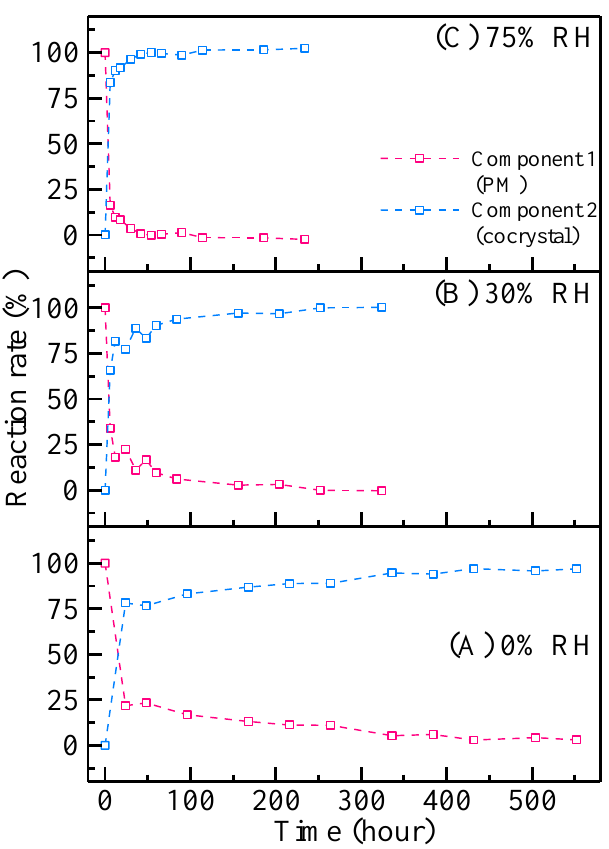
Figure 4. Reaction rate in the 1832–2229 cm –1 region of the FT-IR spectrum. Red and blue lines represent the PM (component 1) and cocrystal (component 2), respectively. ( A – C ) are results obtained under 0%, 30% and 75% RH, respectively.